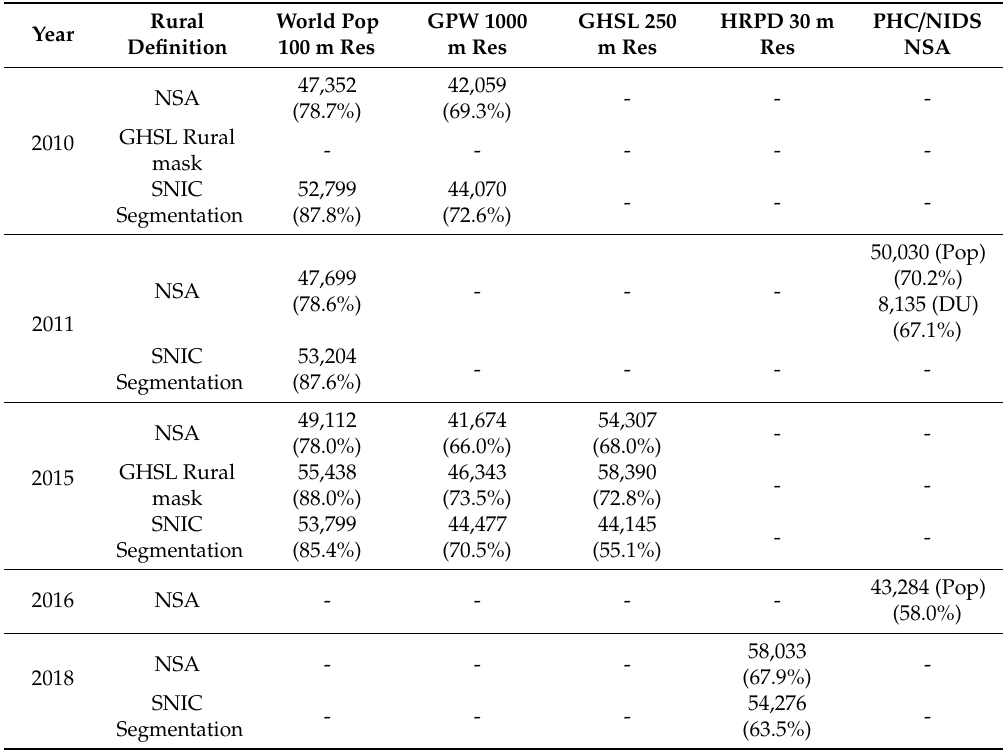
Table 7. Rural population estimated with di ff erent